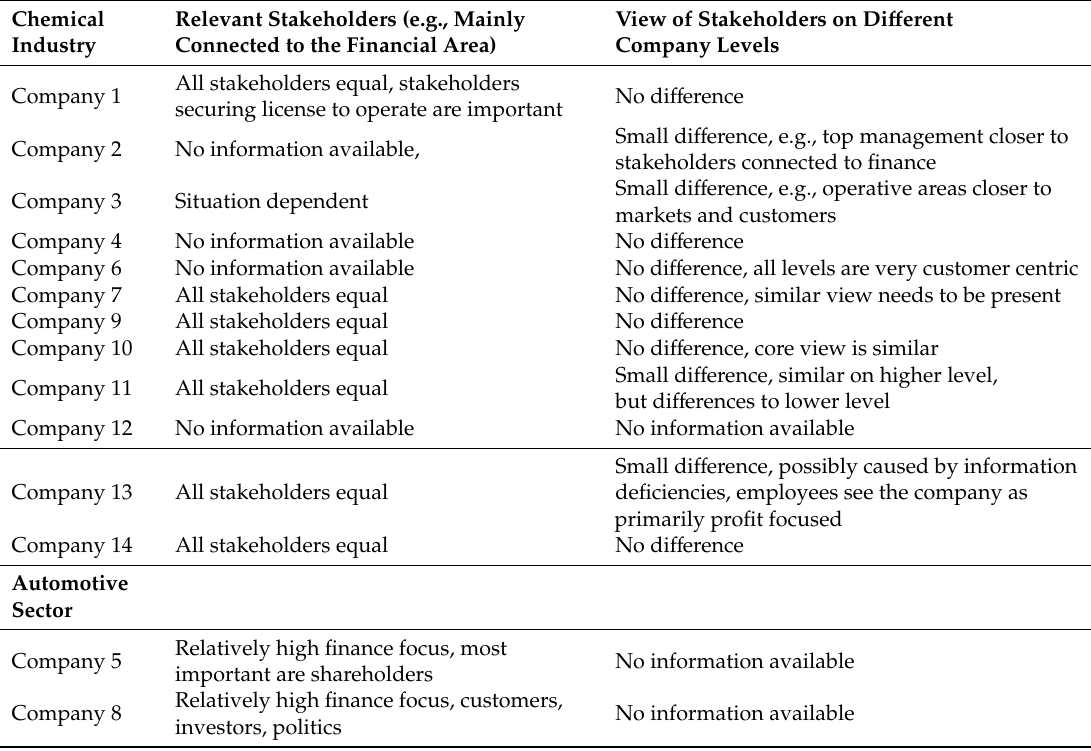
Table 10. Answers to question 14b and 14c on most important company stakeholders, their relevant area and the view of di ff erent organizational levels on company